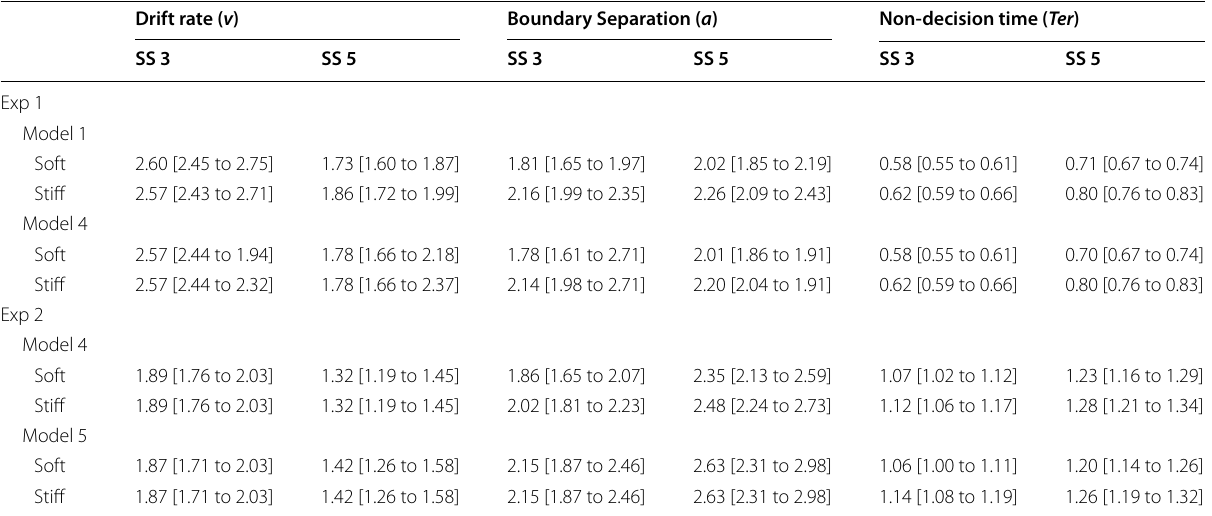
Table 3 Experiment 1 and 2 mean parameter estimates for Model 1 (full model on drift rate, boundary separation and non-decision time), Model 4 (full model on boundary separation and non-decision time, but only an effect of set size on the drift rate) and Model 5 (full model on non-decision time, but only an effect of set size on drift rate and boundary separation) and [2.5 to 97.5] quartiles for the posterior